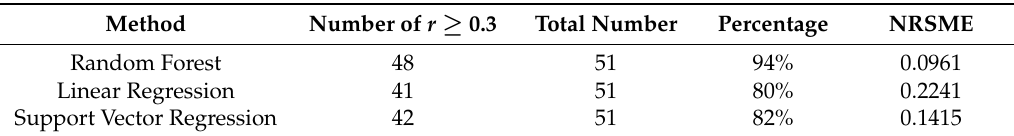
Table 2. Overall smart home (SH) features used to predict the variables of the first smart home (IAQ 1) . We report the classifier that was used, and the number of IAQ variables that are predicted with at least a moderate effect ( r ≥ 0.3).